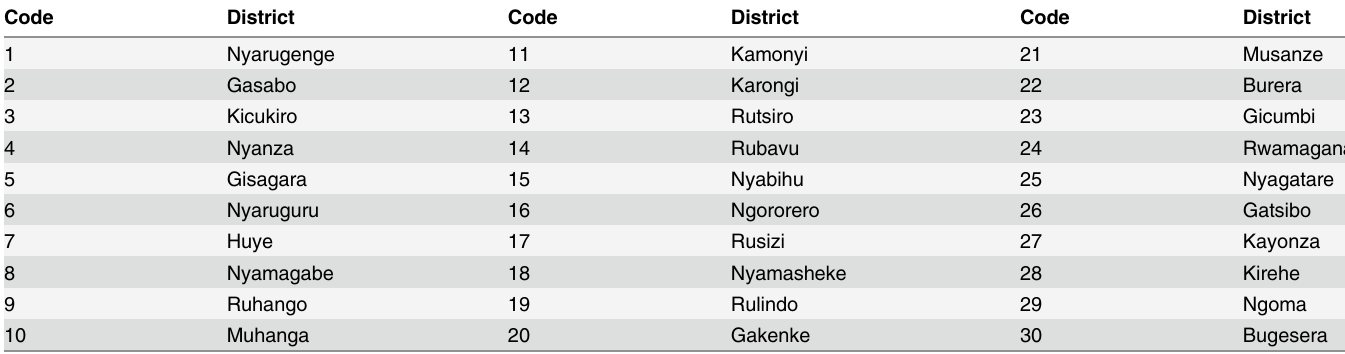
Table 1. Districts of Rwanda and their geographic codes used during the 2010 RDHS.